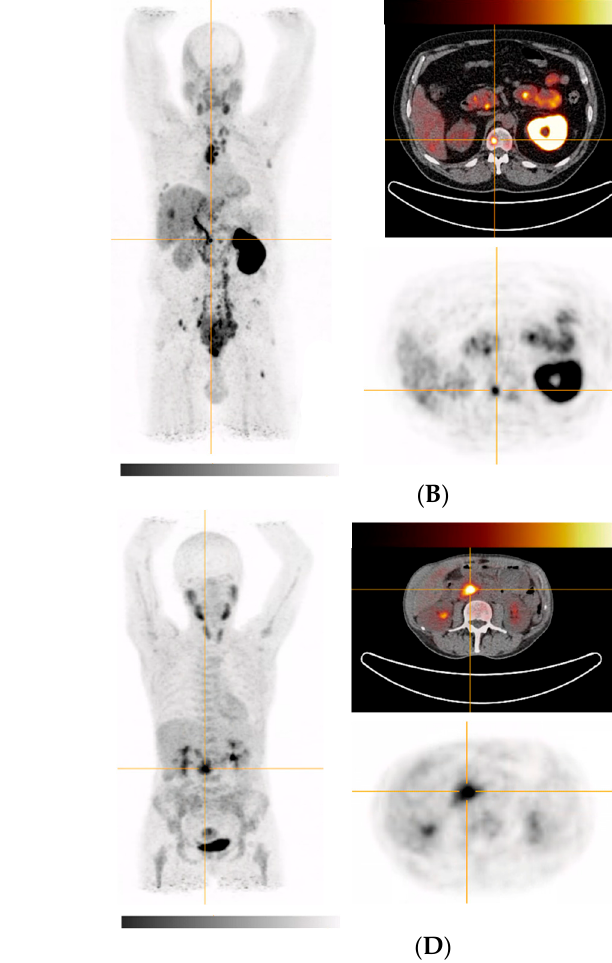
Figure 4. MIPs and transversal images of [ 68 Ga]Ga-DATA 5m .SA.FAPi in cancer patients. Crosshair indicates target lesion (highest tumor SUV max ); ( A ) hepatic metastases of parotid gland tumor; target lesion (primary tumor/liver metastasis): 5.0; ( B ) metastasized prostate cancer; target lesion (bone metastasis in L1 vertebra): 12.7; ( C ) metastasized liposarcoma; target lesion (peritoneal metastases): 10.6; ( D ) primary pancreatic head adenocarcinoma tumor: 10.1.